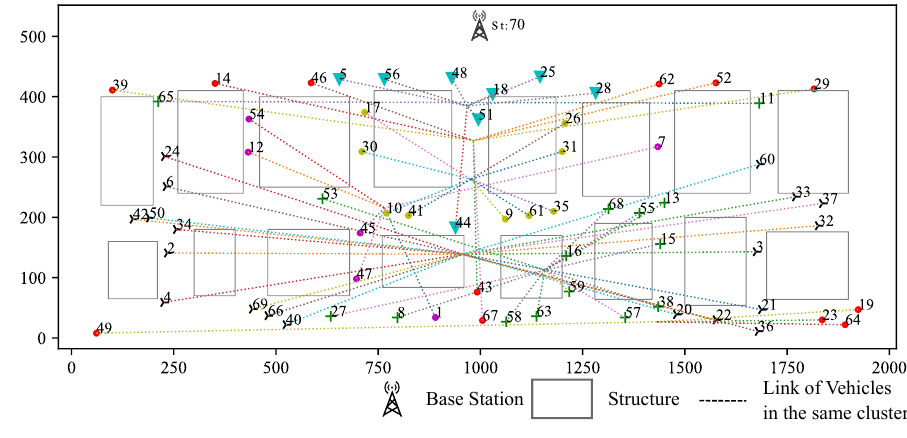
Figure 9. Clustering According to